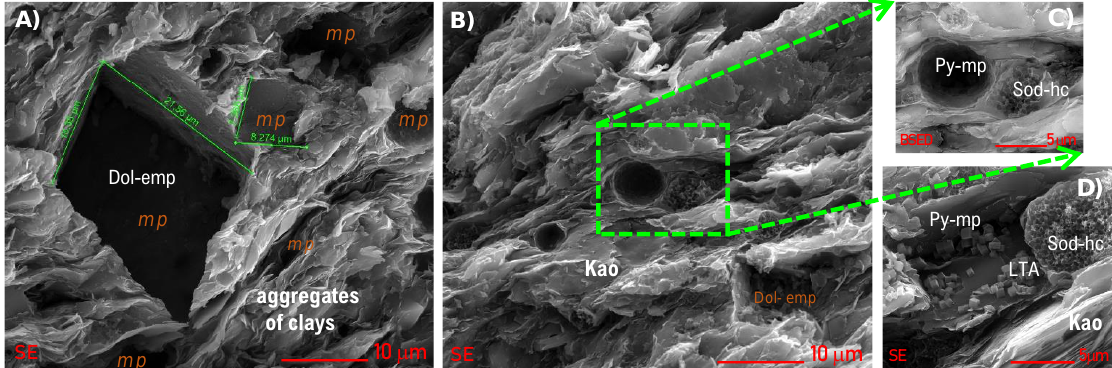
Figure 6. High-resolution SEM photographs showing typical petrophysical properties in materials from the Paja Formation. ( A ) Rock with a clayey matrix (aggregates of clays of kaolinite-type in curly lamellae) and euhedral moldic pores of dolomite (rhombohedra, with faces between 8.2 and 21.5 μ m). ( B ) Micropores by various framboid pyrites and carbonate, towards the bottom, in a reg- olith sample (poorly developed soil, but with higher secondary porosity than fresh rock), which is magnified in ( C ): micropores of honeycomb sodalite and an orbicular cast left by iron sulfide (6 μ m diameter) between kaolinite booklets. ( D ) Another aspect of weathered mudstone: phyllosilicate minerals beside the poral aggregates of sodalite and pyrite are shown (interconnected microporos- ity), in whose cubic mold’s zeolite Na-A crystallized in stacks of “ sugar cubes ” , a fact reported for the first time naturally. Microporosity is symbolized in photomicrographs as mp; emp: euhedral moldic pores; hc: honeycomb; Kao: kaolinite; Dol: dolomite; Py: pyrite; LTA: Na – A zeolite; Sod: sodalite. The role of hydrobiogeochemical reactivity is explained at the end of this article since it is in direct interrelation with other relevant exogenous phenomenologies.